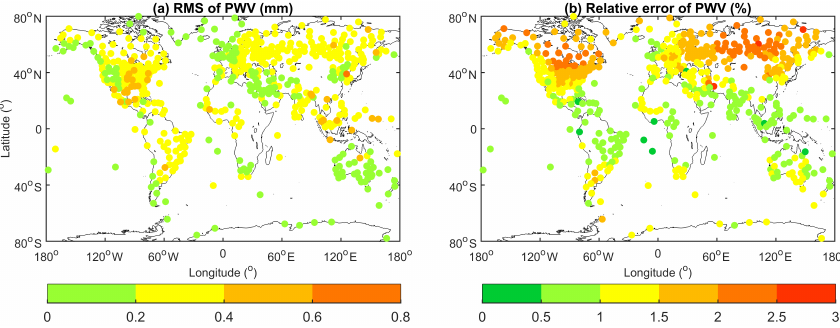
Figure 12. The theoretical RMSE (a) and relative error (b) of PWV resulting from the GWMT-D model using radiosonde observations in